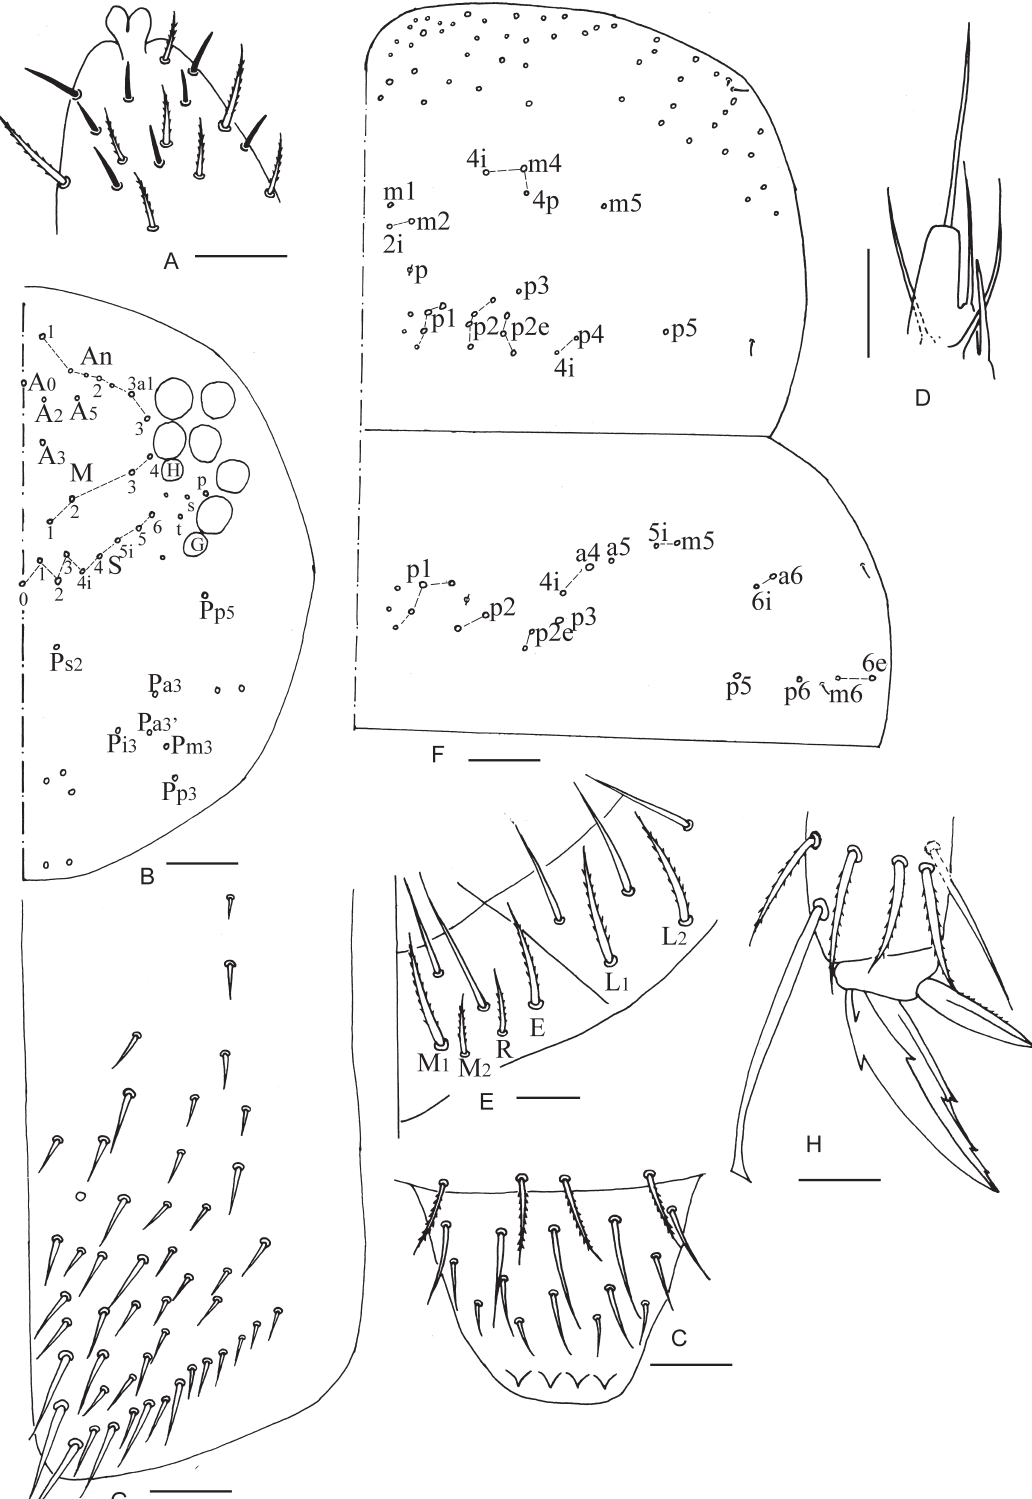
Fig. 5. Willowsia zhaotongensis sp. nov. A . Apex of Ant. IV. B . Dorsal chaetotaxy of head. C . Labrum. D . Lateral process of labial palp. E . Labium. F . Chaetotaxy of Th. II−III. G . Trochanteral organ. H . Hind foot complex. Scale bars: A, C–E, G–H = 15 μm; B, F = 50